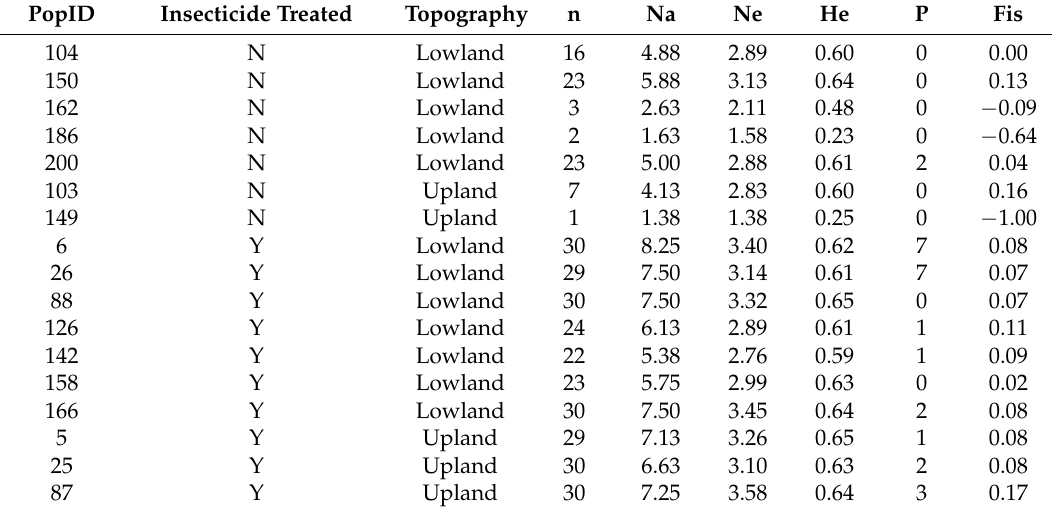
Table 1. Averages for genetic parameters by population, including population name (PopID), whether trees were treated with insecticide (Y = yes, N = no), topographic position of the site (upland or lowland), number of trees sampled (n), average number of alleles (Na), average effective number of alleles (Ne) corrected for sample size, gene diversity (He), number of Private alleles (P) and Inbreeding coefficient